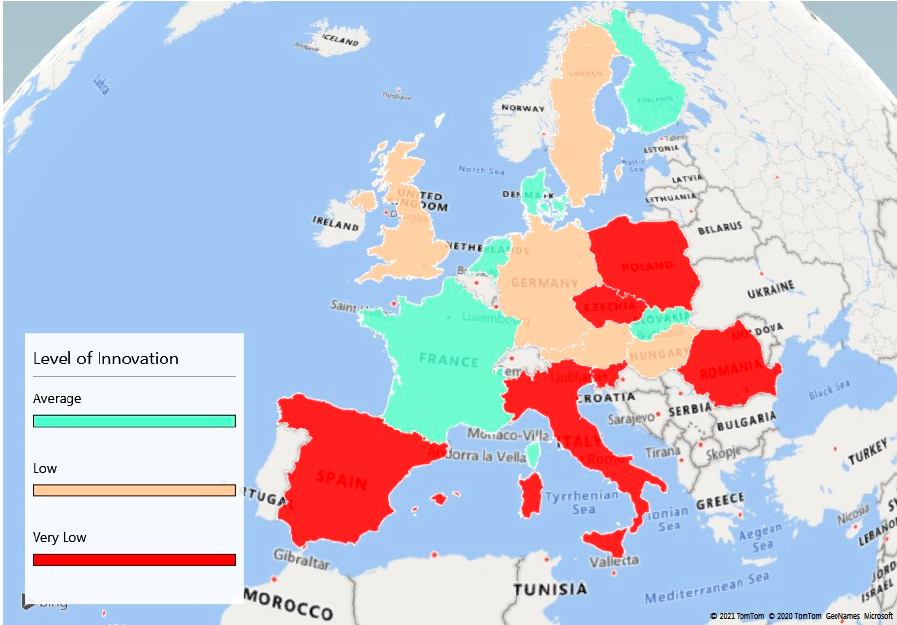
Figure 2. Map of countries based on innovation level in the bioenergy field. Source: authors